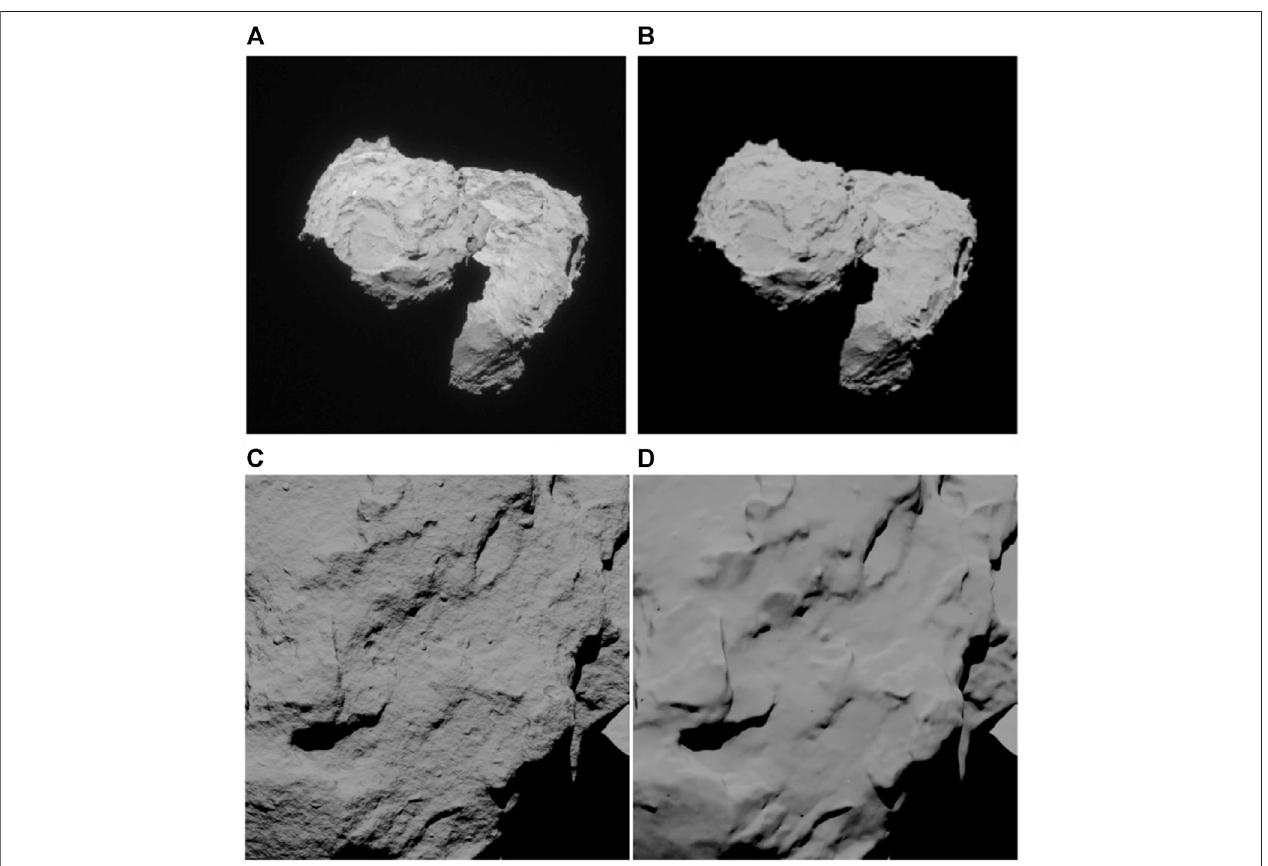
FIGURE 8 | Comparison between real (A) and synthetic (B) images of comet 67P using the Hapke model. The real image is from Rosetta ’ s NAVCAM. Synthetic image of comet 67P with (C) and without (D) procedural terrain generation. Bump mapping is used, in combination with multiple terrain-noise functions. The Hapke model is used for re fl